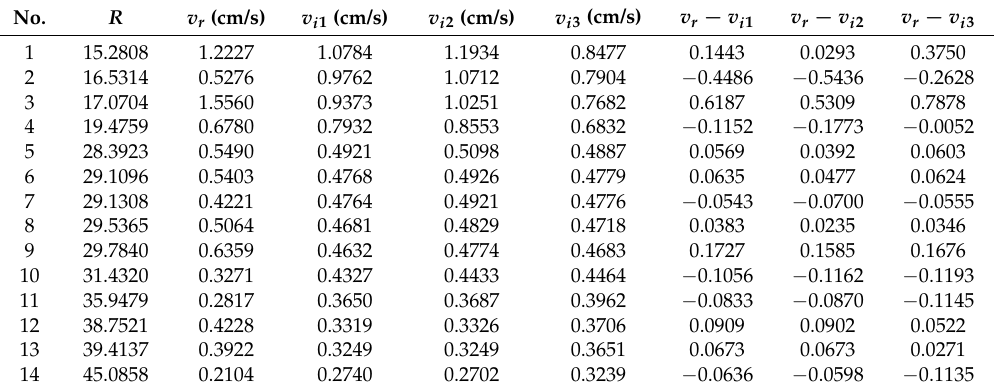
Table 7. Survey of recorded and calculated rock mass oscillation velocities for models 1, 2 and 3.